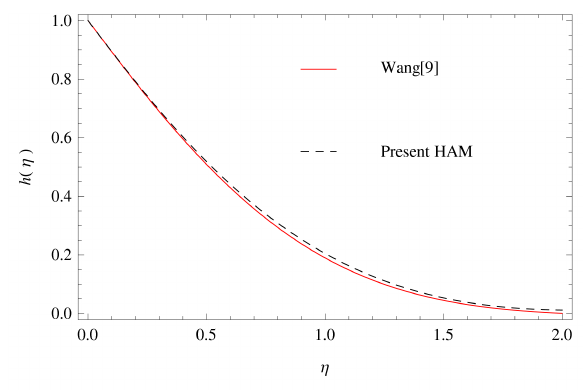
Fig. 24: Comparison of Wang [9] and HAM solution for velocity func- tion k ( η )